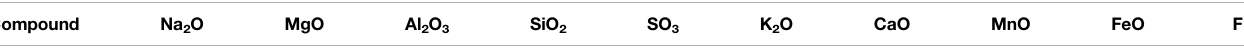
TABLE 3 | Composition of mould slag powder was measured using ICP, all wt%. Compound Na 2